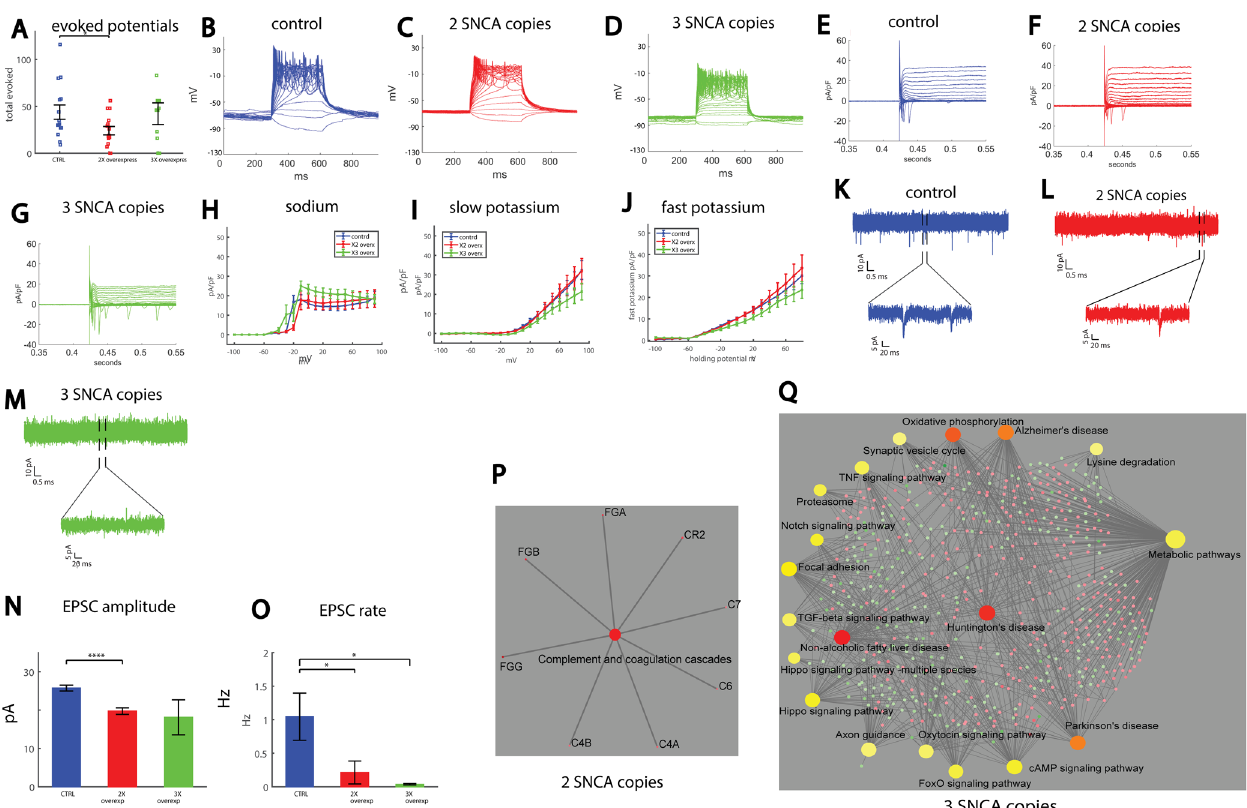
Fig. 1 Reduced synaptic activity in neurons of patients with two or three copies of the SNCA gene (denoted as 2X and 3X). A Neurons derived from the 2X patient display reduced excitability compared to controls. Representative evoked potential recordings of a control B , 2X patient C , and 3X patient D . Representative traces of sodium and potassium currents in control individuals E , 2X patient F , and 3X patient G . H Sodium currents of neurons from 3X patient opened at a less depolarized potential than control DA neurons, whereas those derived from the patient with the double copy opened at a more depolarized potential. I Slow potassium currents are reduced in DA neurons derived from 3X patient compared to controls. J Fast potassium currents are reduced in DA neurons derived from 3X patient compared to controls. Example traces of recordings of synaptic currents in DA neurons derived from a control individual K , the 2X patient L , and the 3X patient M . The lower image in each is a zoom of the segment denoted by the black bars in the upper image. N The mean amplitude of synaptic currents is reduced in DA neurons from 2X patient compared to controls. O The average rate of synaptic events is reduced in DA neurons derived from 2X patient and further reduced in 3X patient. P Signaling network analysis with the top enriched KEGG pathways for the 2X patient-derived neurons compared to the controls. Q Signaling network analysis with the top enriched KEGG pathways for the 3X patient-derived neurons compared to the controls. In this fi gure and the next fi gures, asterisks represent statistical signi fi cance by the following code: * p value < 0.05, ** p value < 0.01, *** p < 0.001, **** p < 0.0001. Error bars represent the standard error in this fi gure and in the next fi gures unless stated